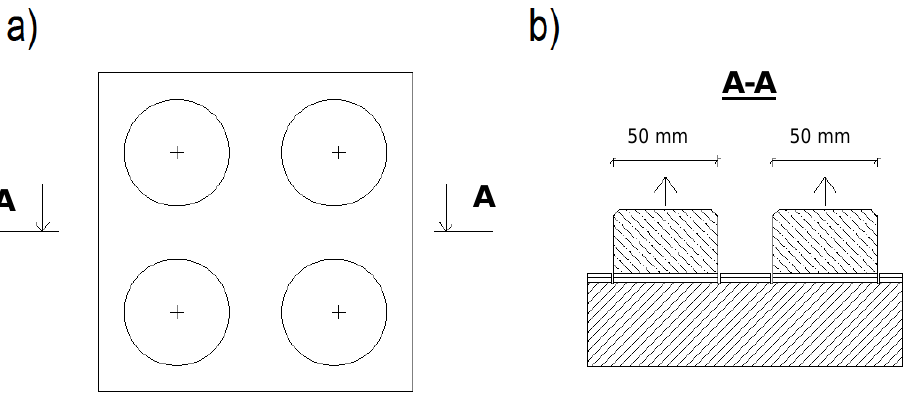
Figure 7. Diagram of the arrangement of the discs on the sample: ( a ) view, ( b ) cross-section.